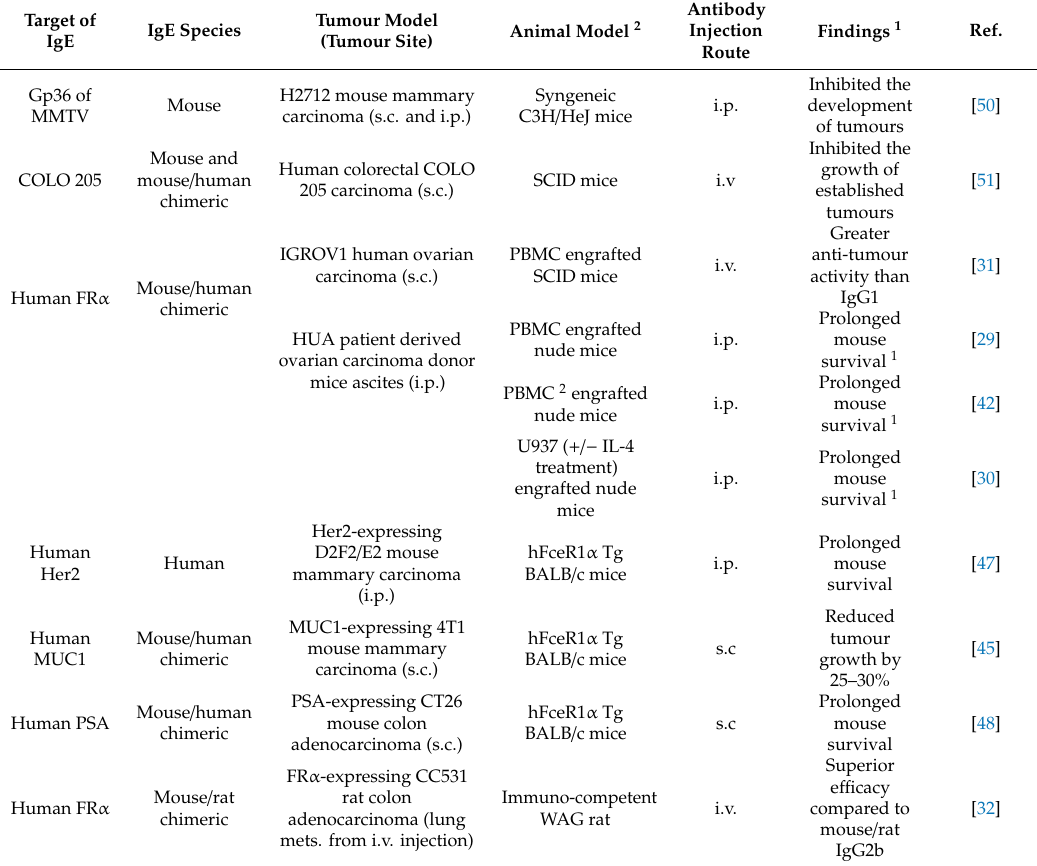
Table 2. In vivo pre-clinical assessments of IgE antibody therapy e ffi